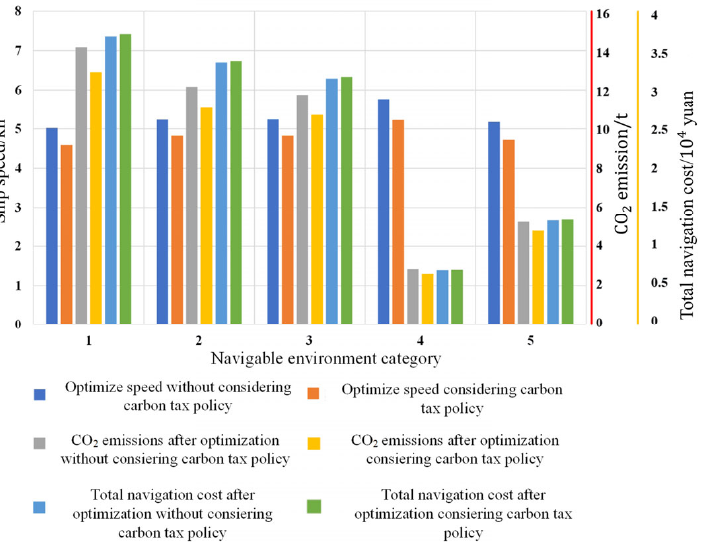
Figure 12. Comparison of optimization values with and without considering the carbon tax.